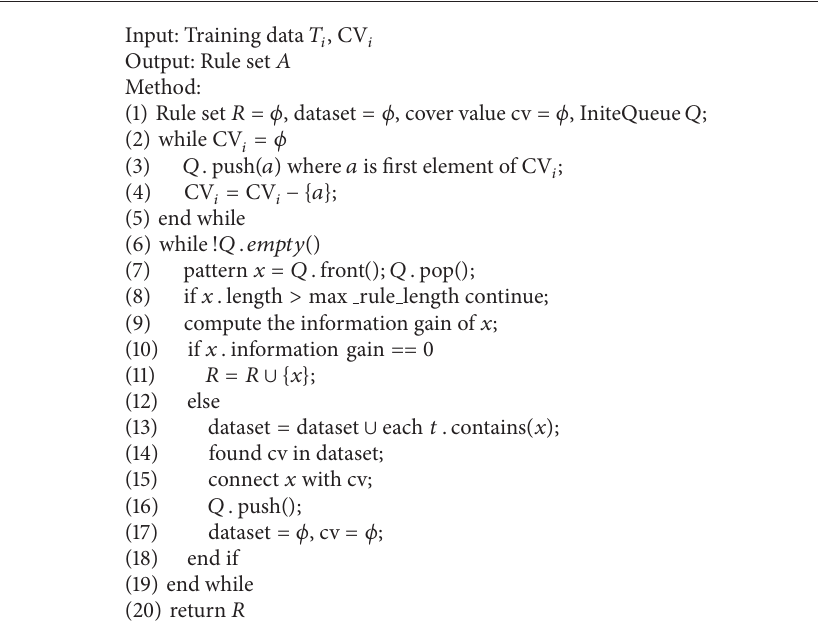
Algorithm 3: Inducing rule set 𝐴 .